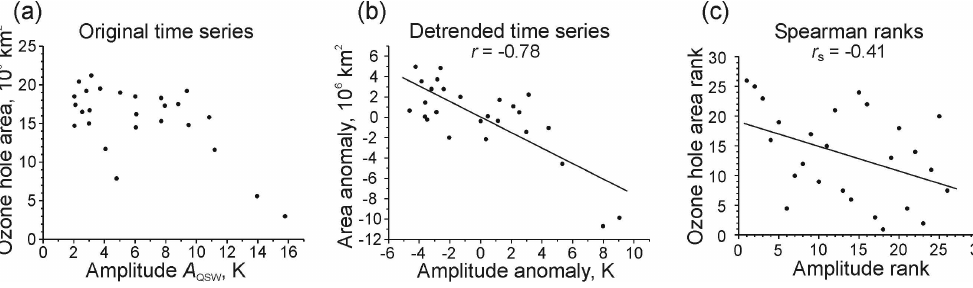
Fig. 3. Relationships between the variations of the ozone hole area in October and the QSW amplitude in August at 70 ◦ S, 10hPa, during 1985–2010: (a) original data, (b) detrended anomalies and (c) Spearman ranks.